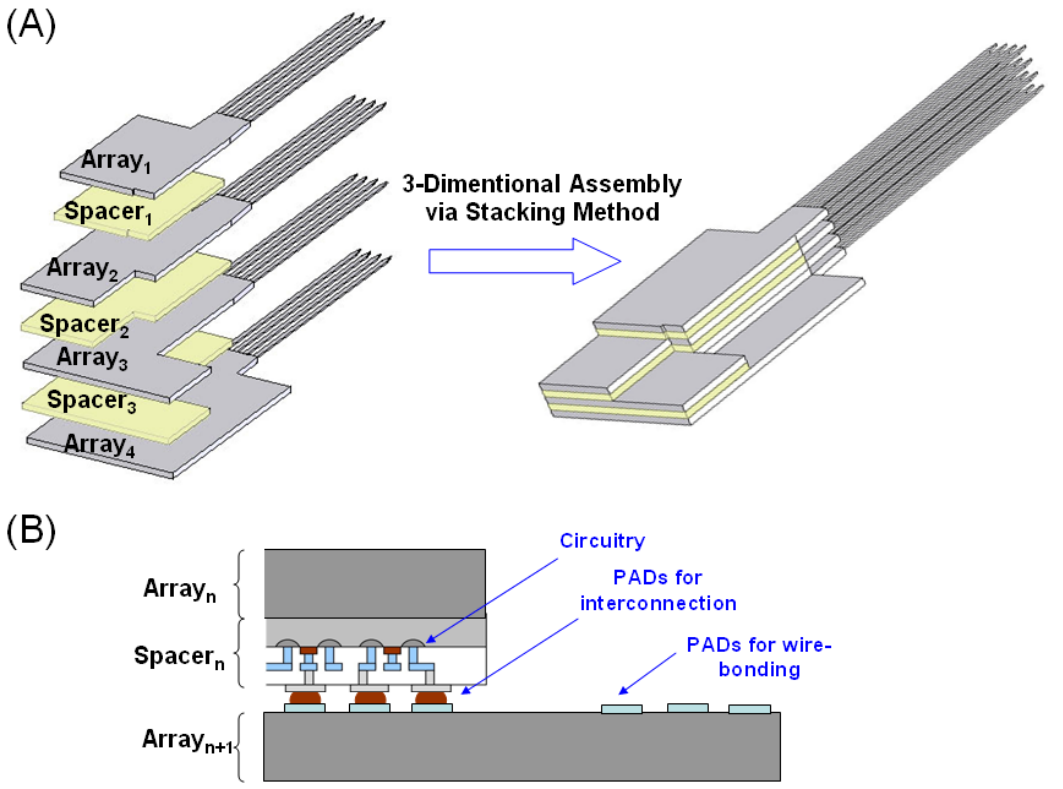
Figure 1. (A) The schematic of stacking a 4 × 4 3-D microprobe array. (B) Spacers can